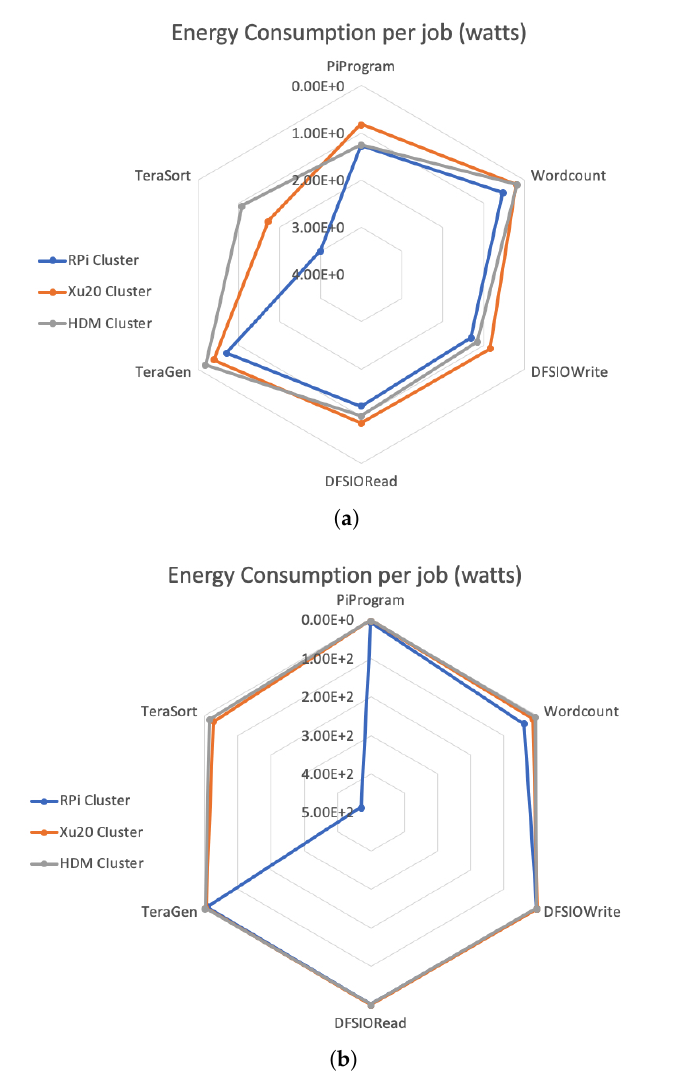
Figure 8. Energy consumption in clusters for all benchmarks with: ( a ) lowest parameter settings; and ( b ) highest parameter settings.